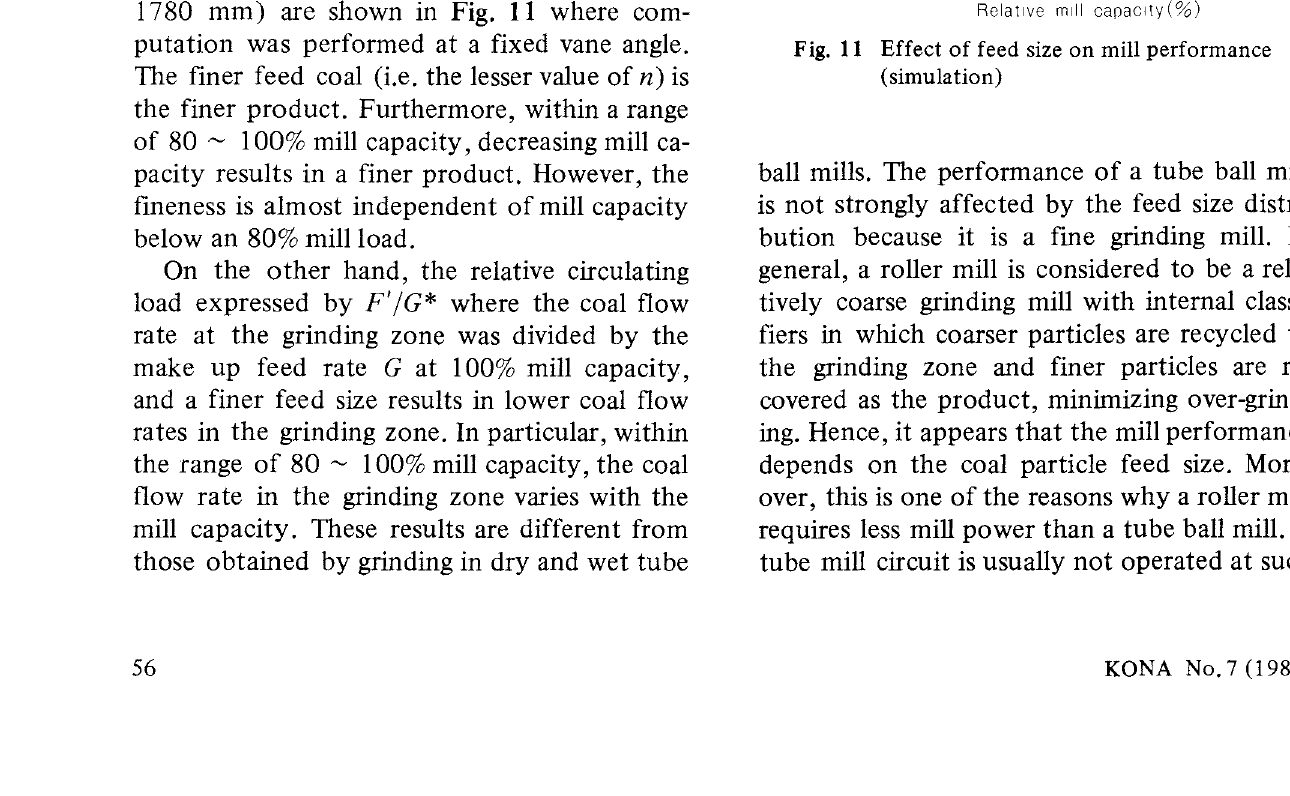
Fig. 9 Comparison of simulated and operating capacities and fineness for large-scale mills